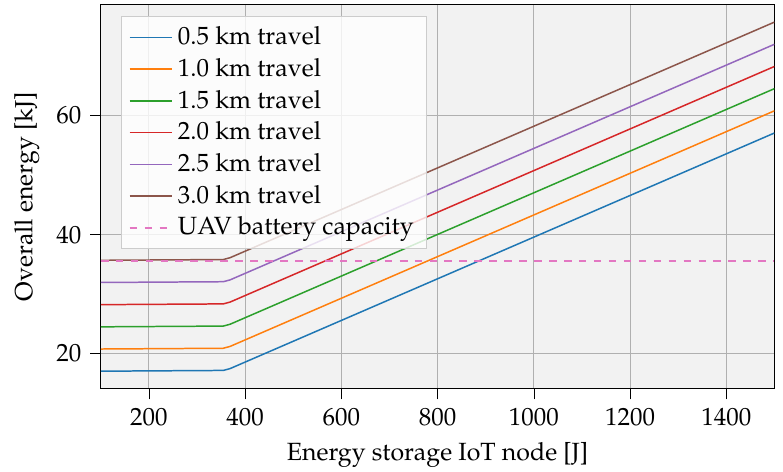
Figure 12. Maximum IoT storage capacity, limited by the battery capacity of the UAV, represented by a dotted line. The UAV battery capacity is 9.62Wh, and the maximum charge power P ch,max is set to 1W. The energy storage IoT node involves an LTO cell with a charge rate of 10C.